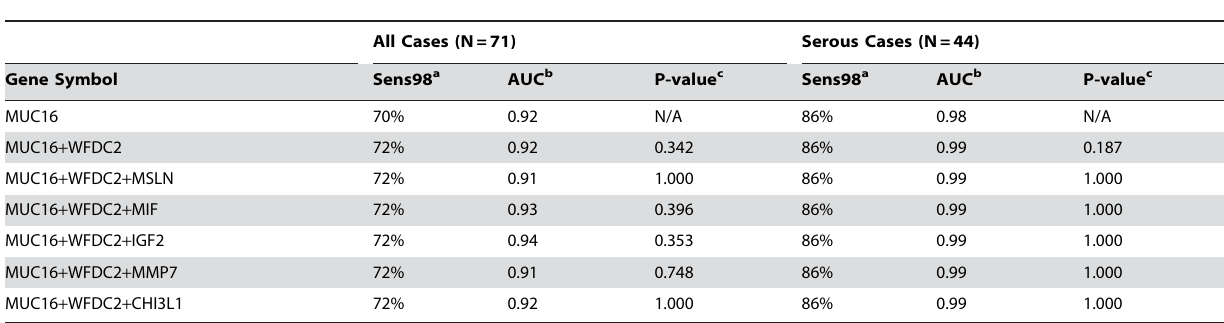
Table 4. Combination marker